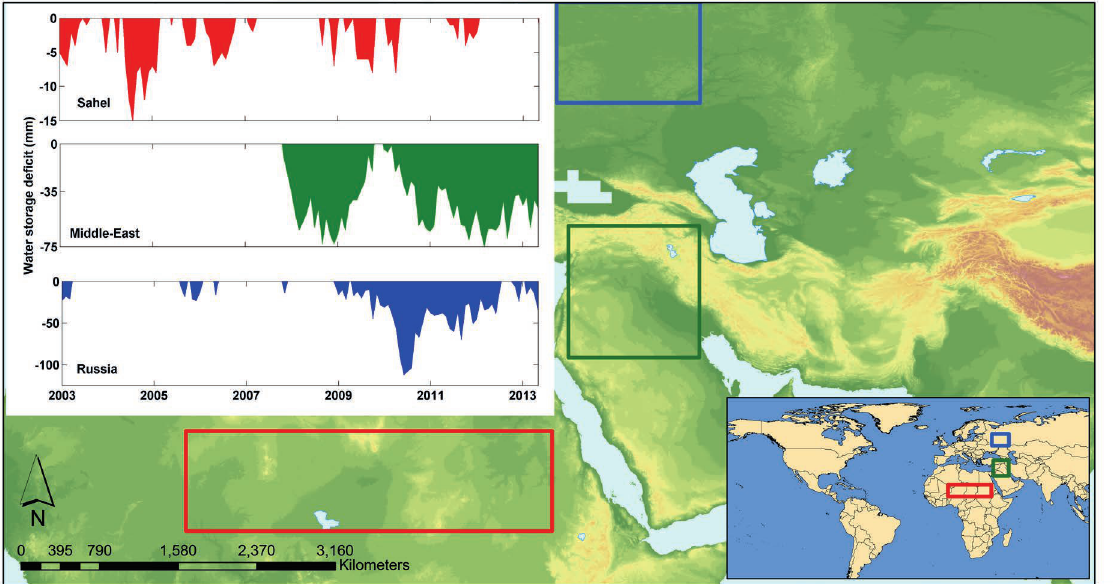
Fig. 1 Location of the study regions: Russia (blue box), Middle East (green box) and Sahel (red box). For the same regions, monthly water storage deficits from 2003 until 2013 are shown in the inner